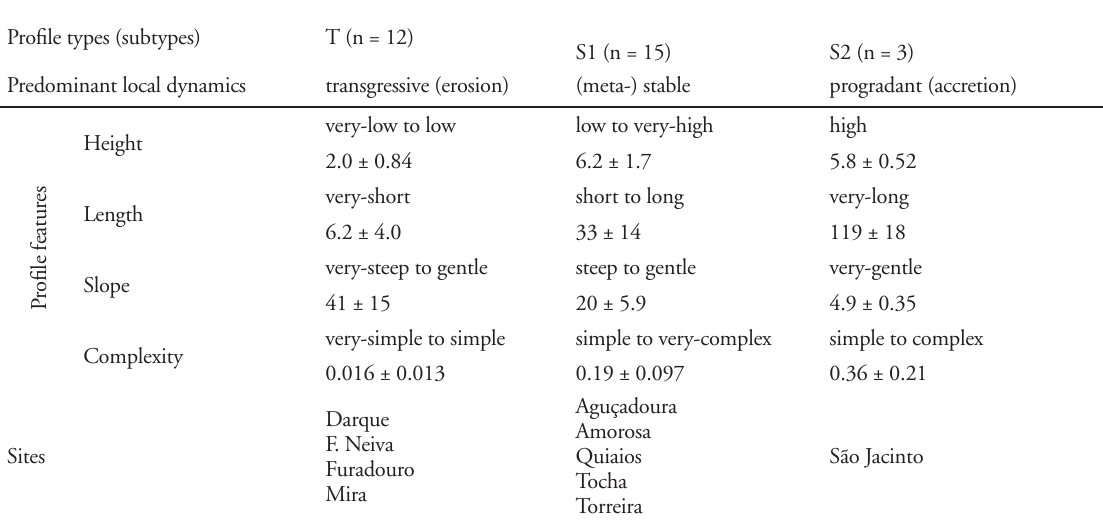
Table 2. Types (and subtypes) of profiles according to the four major topographic attributes assessed (length, height, slope, and com- plexity) and corresponding mean (± SD)